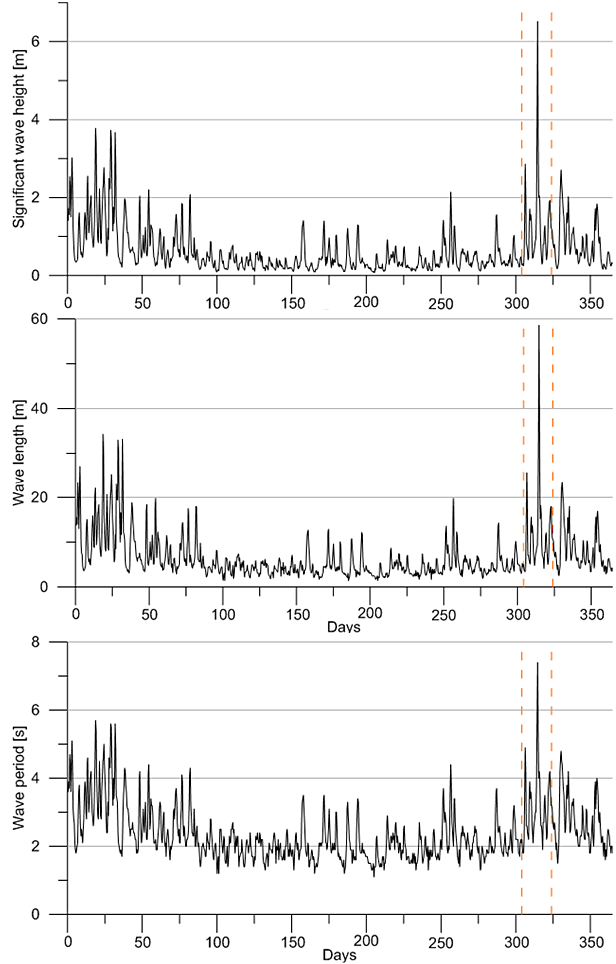
Figure 19. Time series of significant wave height, wave length and wave period at the point indicated on Fig. 16 in 2007. Orange dashed lines indicate the period between 1 and 20